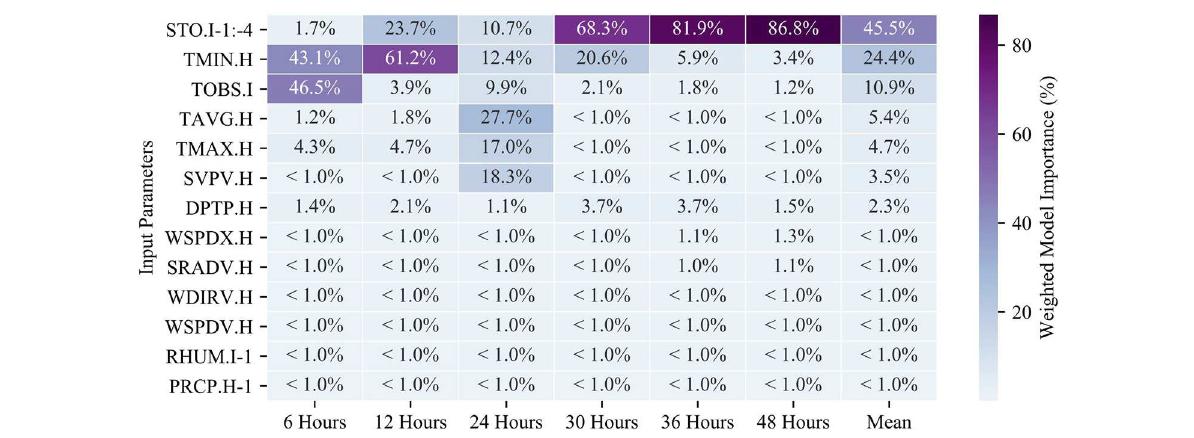
FIGURE6 A heatmap of the weighted model importance of the RF model features (as described in Table 1). The listed values are the sum of all feature importances for the given input parameter (the actual number of features is much larger after feature engineering on the time-series data). Each RF model (columns) add up to a total of 100%.